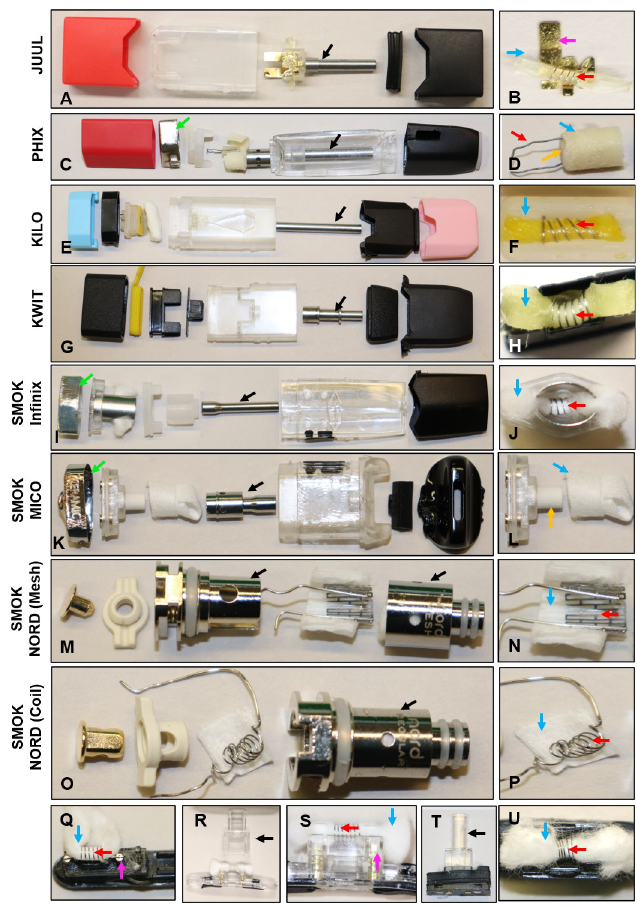
Fig 2. Anatomy and internal design of atomizers from pod ECs. JUUL ™ (A-B), PHIX (C-D), Kilo 1K (E-F), KWIT Stick (G-H), SMOK Infinix (I-J) SMOK Mico (K-L), SMOK NORD 0.6-ohm (mesh) filament (M-N), SMOK NORD 1.4-ohm (coil) filament (O-P), Suorin Air (Q), Suorin Drop (R-S) Suorin Edge (T-U). JUUL ™ , PHIX, and Kilo 1K are prefilled pods. KWIT Stick is a prefilled and refillable pod. SMOK and Suorin pods are refillable. Specific key components are indicated by colored arrows: air tube = black; cotton/silica wick = blue; ceramic wick = orange; filament and thick wires = red; connector plate/pin = pink; outer casing = green. gray squares represent components that were present but not analyzed. Due to similar organic materials being used in components such as the wick, only selected pods were evaluated in the SEM. SEM images of all components and their corresponding elemental maps arranged from left to right based on high relative abundance are shown in Figs 4–6, and S3–S5 Figs. Nickel, iron, and chromium alloys in the form of Elinvar (nickel, iron, chromium alloy) (36.4%), nichrome (nickel and chromium) (36.4%), stainless steel (iron and chromium) (18.2%), or nickel (9.1%) were the most abundant elements in the filaments (Figs 3A and 4A- 4FF). Some filaments also contained minor amounts of silicon, aluminum, titanium, and molybdenum. Within the SMOK (NORD, Mico, and Infinix) brand, filament composition and structure varied between products. While the 0.6-ohm NORD mesh filament was mainly iron and chromium (Figs 3A and 4E-4H), the Mico was mainly nickel with minor amounts of silicon, aluminum, and iron (Fig 4I–4M). The Infinix and the 1.4-ohm NORD coil filaments were mainly nichrome (Fig 4N–4P and 4KK-4NN). The filaments in the Suorin (Air, Edge,